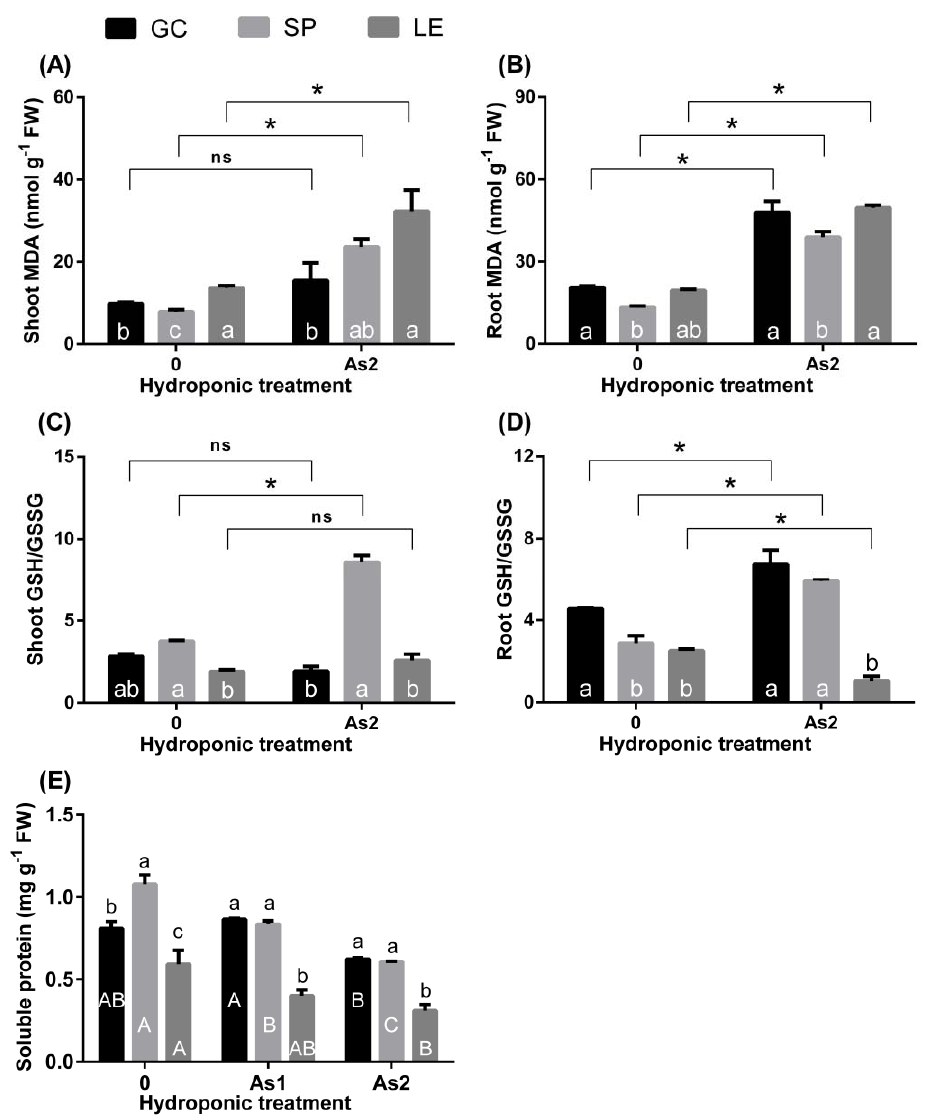
Figure 6. MDA ( A , B ), GSH/GSSG ratio ( C , D ), and soluble protein ( E ) content in the vegetables under hydroponic As treatment. Note: Different lowercase letters in the figure indicate comparisons between different vegetables under the same treatment; different uppercase letters indicate the comparison of the same vegetable under different treatments (5% levels). The symbol * indicates that the difference between values is significant at the respective 5% levels. The error bars in the graph indicate the SEM (standard error of the mean).